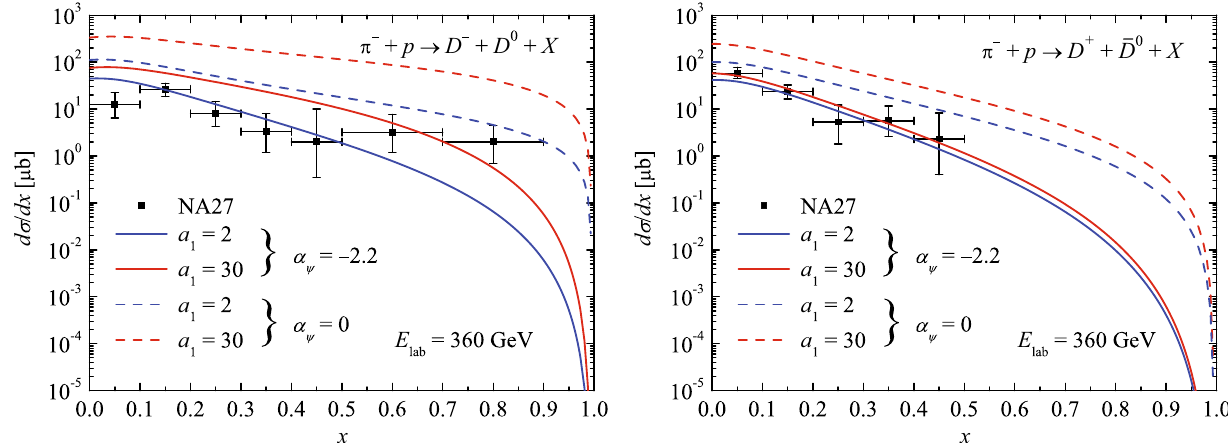
Fig. 7 Differential cross sections of “leading” D − / D 0 mesons (left) and “nonleading” D + / ¯ D 0 mesons (right) in π p collisions at E lab = 360 GeV. Calculations for α ψ ( 0 ) = − 2 . 2 (solid line) and α ψ ( 0 ) = 0 (dash). Points are the data of experiment [48]